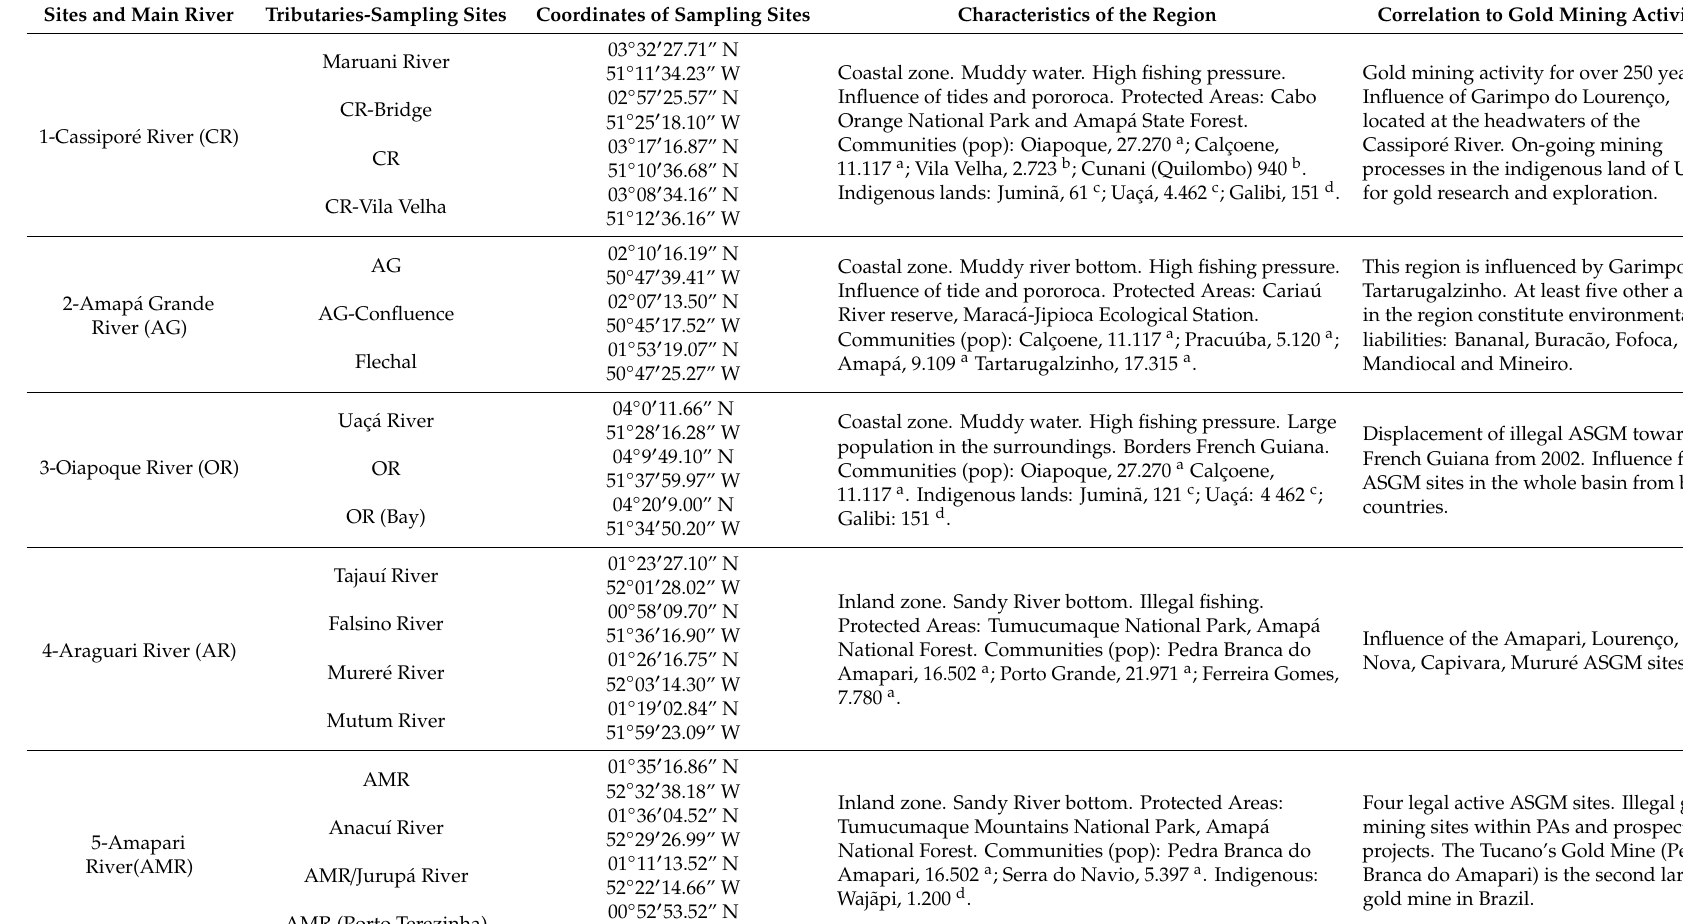
Table 1. Description of the sampling sites and the surrounding